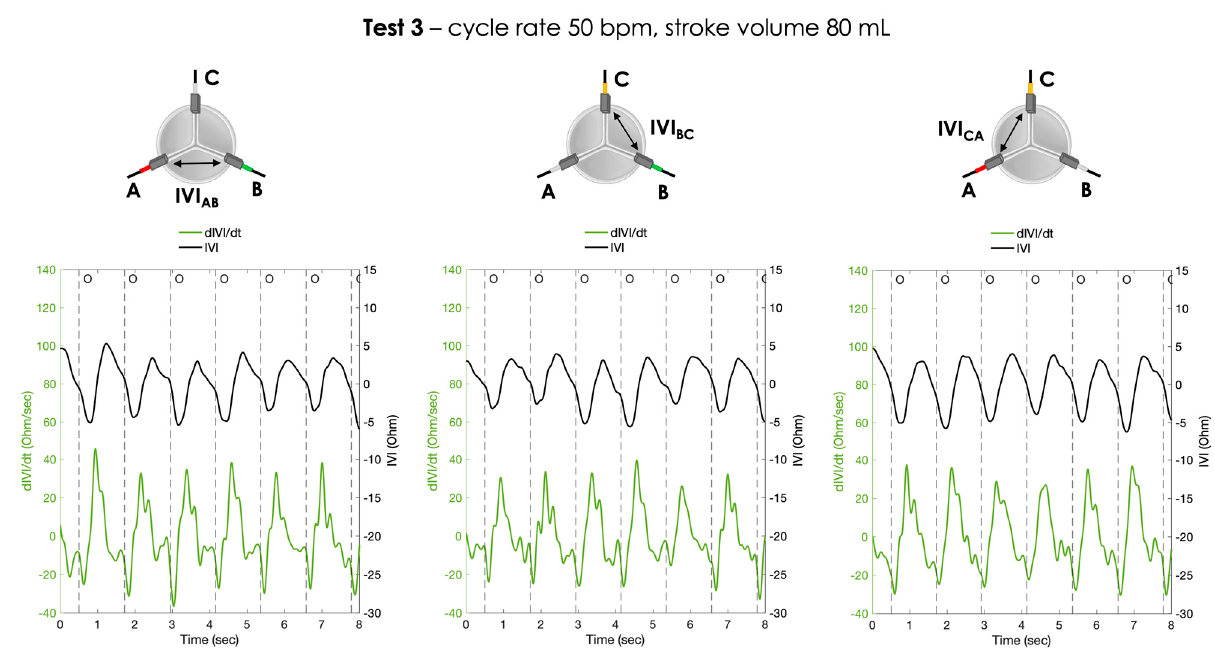
Figure 10. The IVI signal (black line) and the corresponding first derivative dIVI/dt (green line) obtained for the three pairs of electrodes during Test 2 (cycle rate 50 bpm, stroke volume 70 mL). AB ( left ), BC ( center ) and CA ( right ). O = start of valve opening identified with the low peak of the aortic pressure.